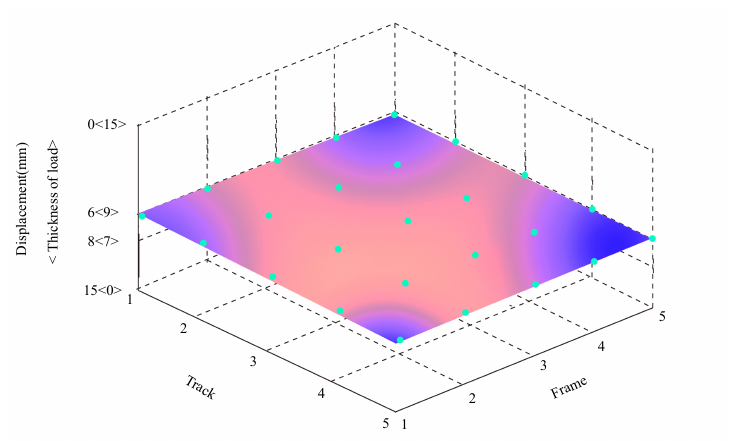
Figure 11. Pressure output surface of flocking